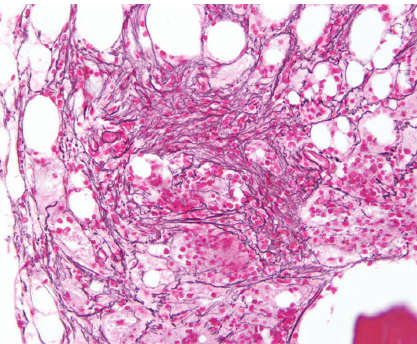
Figure 2: Increased reticulin deposition resulting in fibrotic bone marrow.